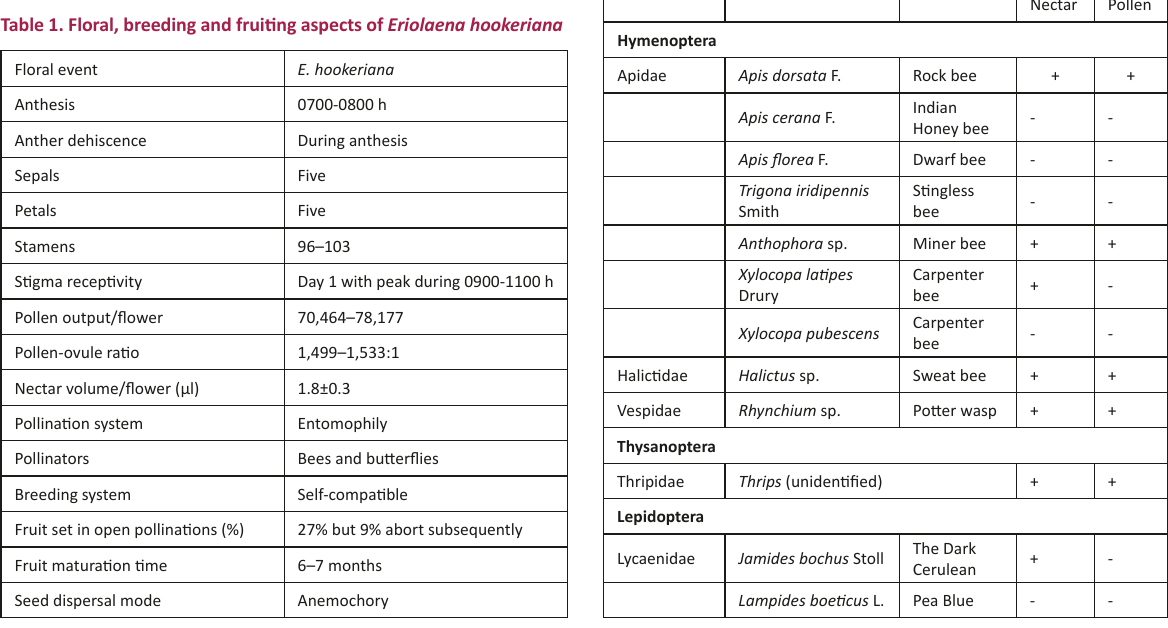
Table 2. List of insect foragers and forage collected from the flowers of Eriolaena hookeriana Order/